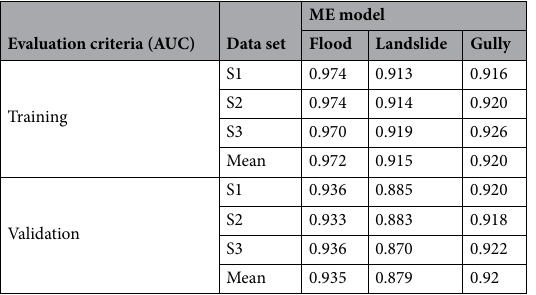
Table 5. Predictive performance of models based on three sample data sets (S1, S2, and S3) in the training and validation step.